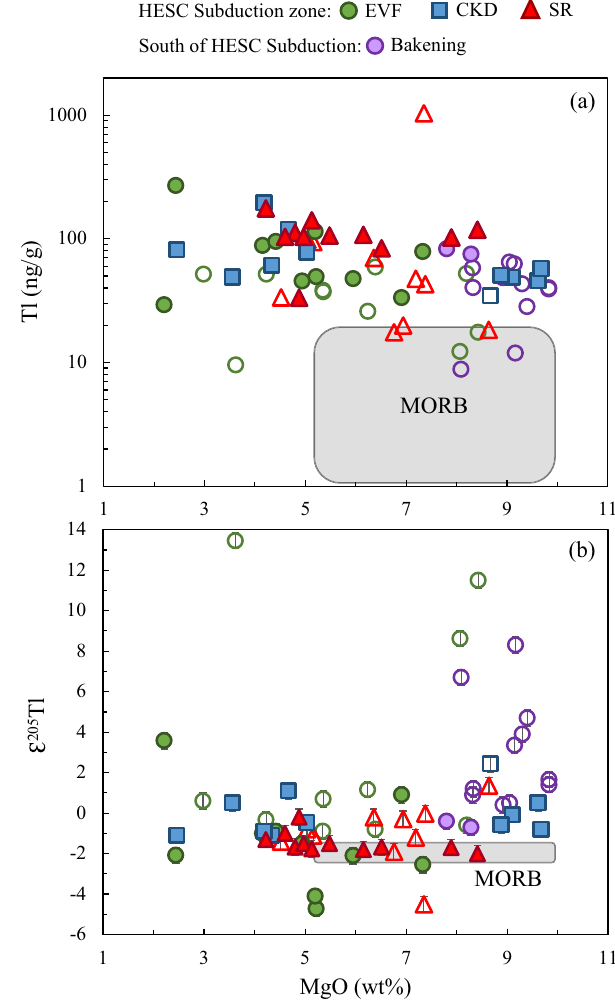
Fig. 3 | Thallium concentration and isotope characteristics of Kamchatka arc lavas. MgO (wt%) plotted against ( a ) Tl concentrations and ( b ) Tl isotope compo- sitions for all Kamchatka lavas investigated in this study. Also shown is the mid- ocean ridge basalt (MORB) 58,66,67,75 . Note that the legend colors follow that of the map in Fig. 1 and are the same for all subsequent fi gures with lavas from multiple locations. Open symbols represent fi ltered Kamchatka lavas for degassing and ocean-island-basalt (OIB) components in their mantle source.